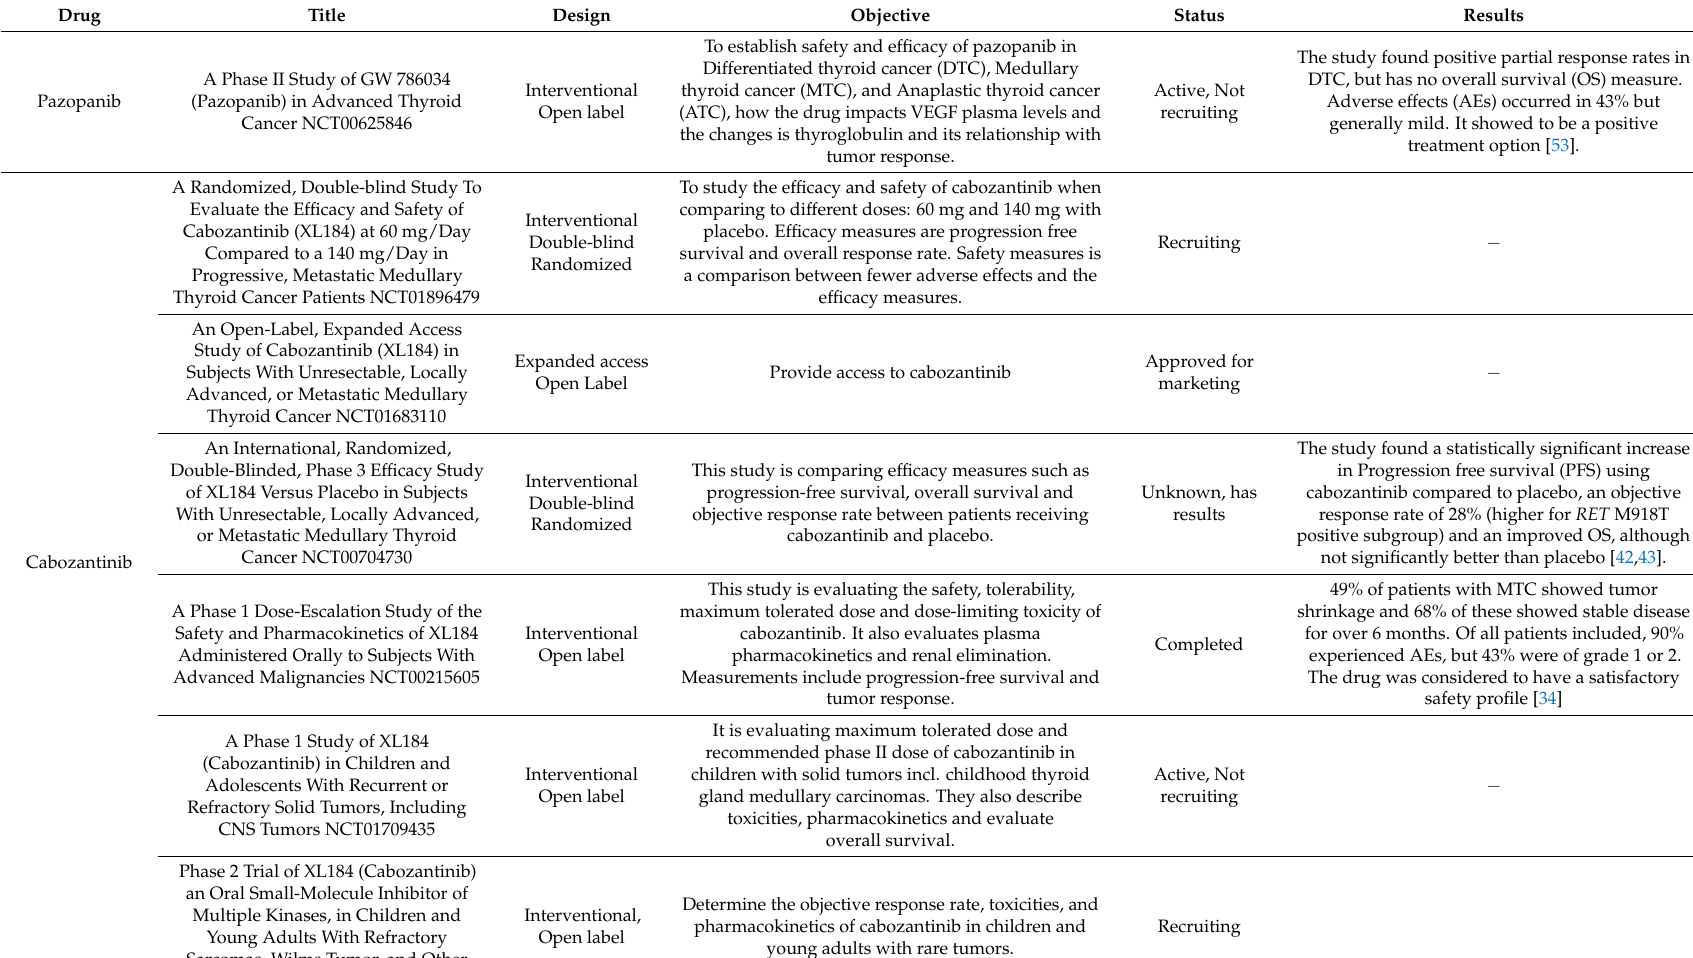
Table 3. Overview of currently ongoing clinical trials studying pazopanib, cabozantinib, and vandetanib in MTC